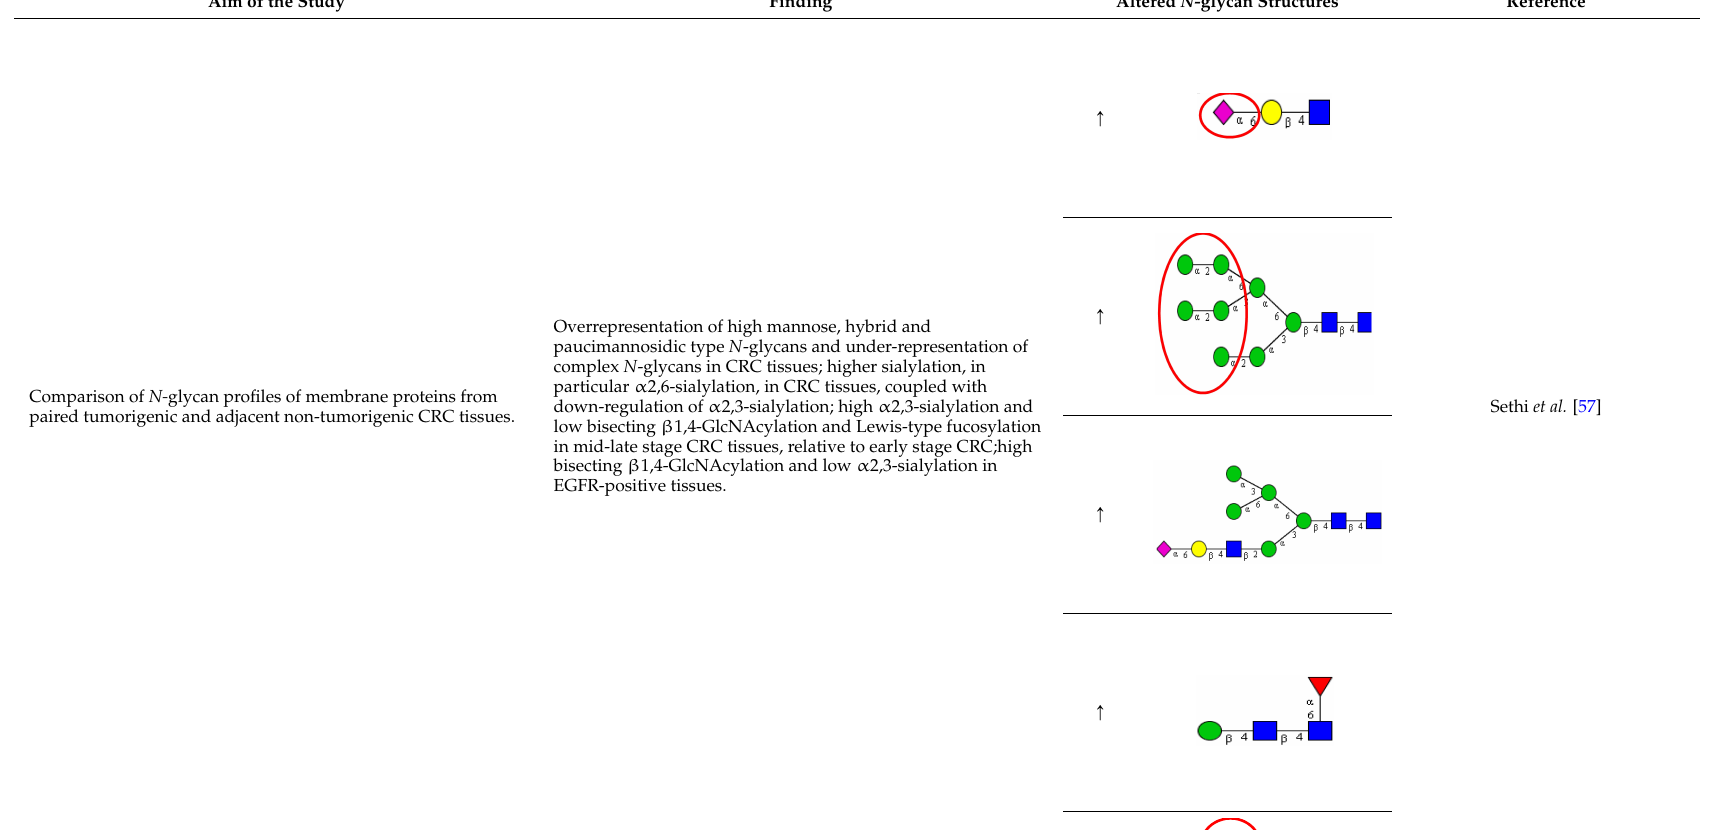
Comparison of N- glycan profiles of membrane proteins from paired tumorigenic and adjacent non-tumorigenic CRC